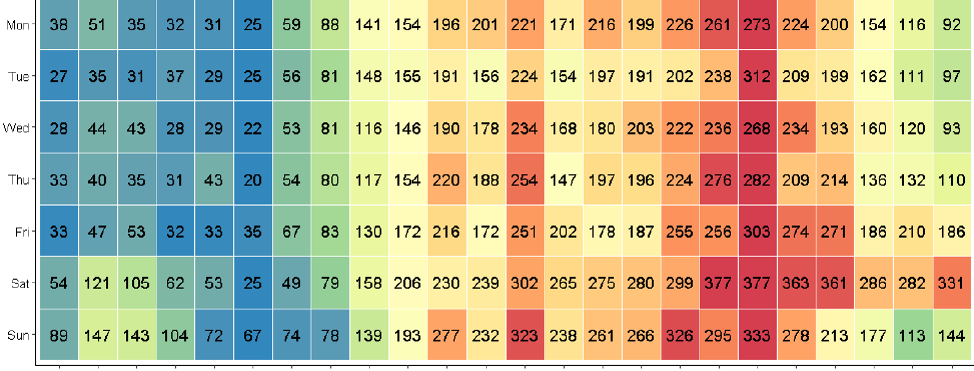
Figure 1. Case distribution by day and time of injury. Characteristics of burn injuries occurring during peak times for each country are summarized in Table 2. Australian patients injured during the peak injury time had a median (IQR) age of 27 (6–48) years, while New Zealand patients had a median (IQR) age of 18 (1–40) years. A smaller proportion of adults and older were injured in New Zealand peak times, while a greater proportion of paediatric patients were injured during peak times (Figure S2). In both countries, scalds accounted for the greatest proportion of injuries during peak times, resulting from water spilt from a saucepan, kettle, jug,